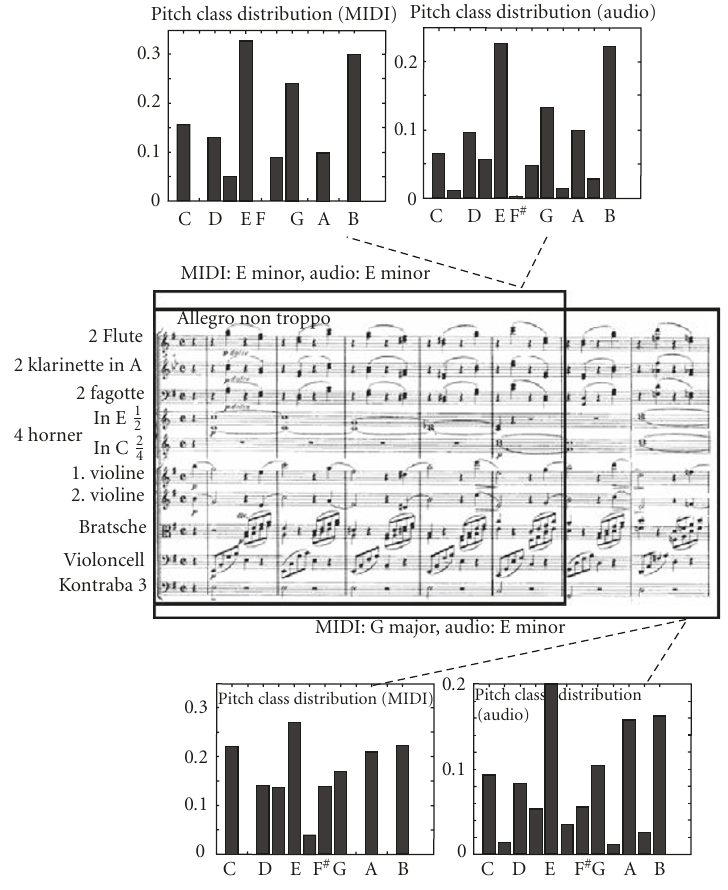
Figure 5: Pitch-class distributions of Brahms symphony number 4 in E